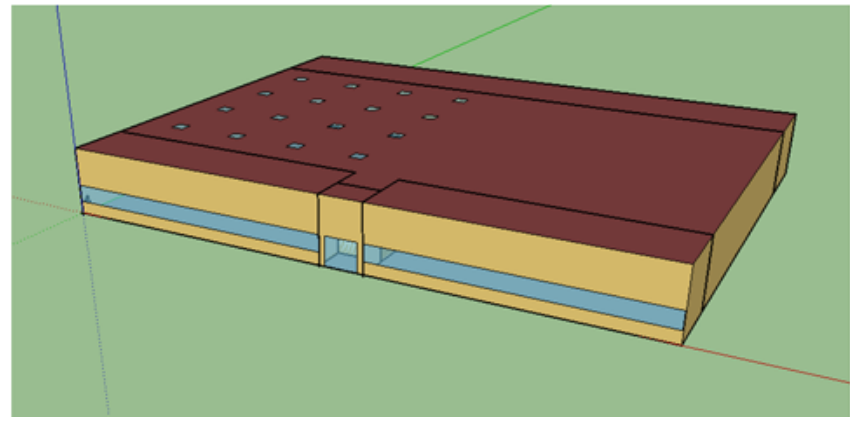
Figure 3. Detailed geometry for the retail standalone prototype building model.